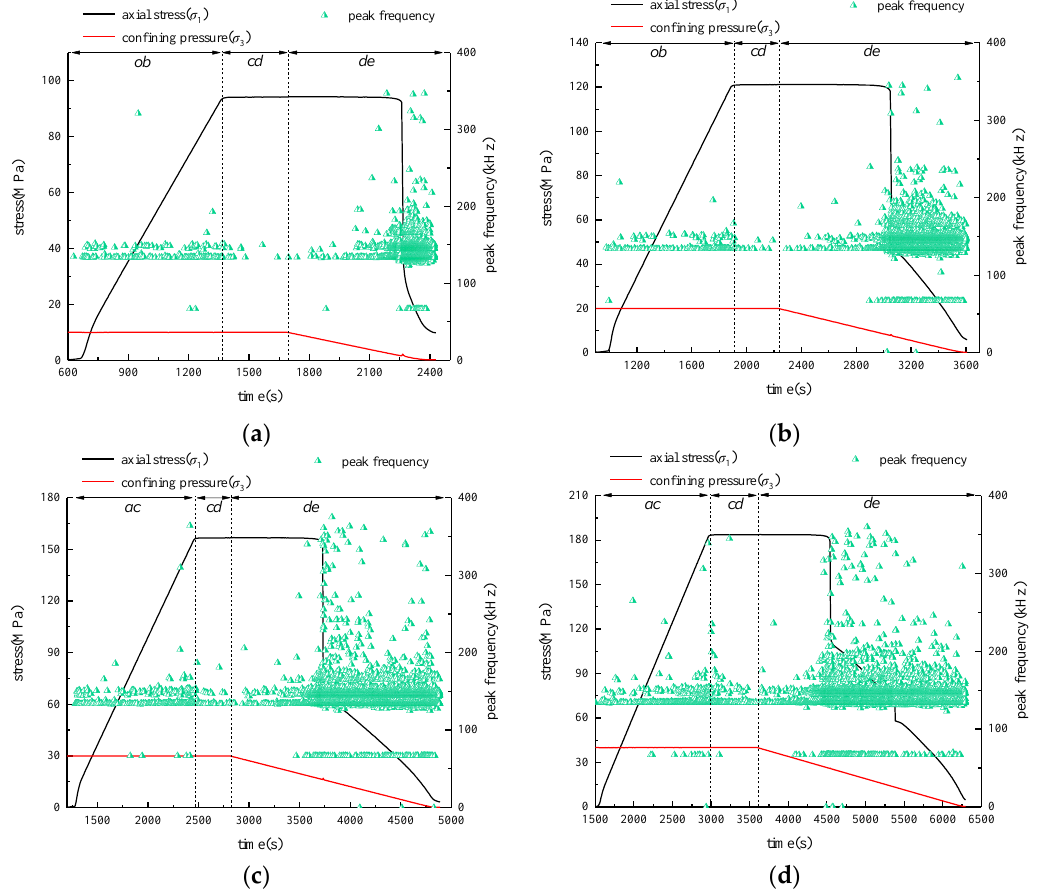
Figure 8. Peak frequency-stress-time relationship of sandstone unloading under different initial confining stresses. ( a ) σ 3 = 10 MPa; ( b ) σ 3 = 20 MPa; ( c ) σ 3 = 30 MPa; ( d ) σ 3 = 40 MPa.